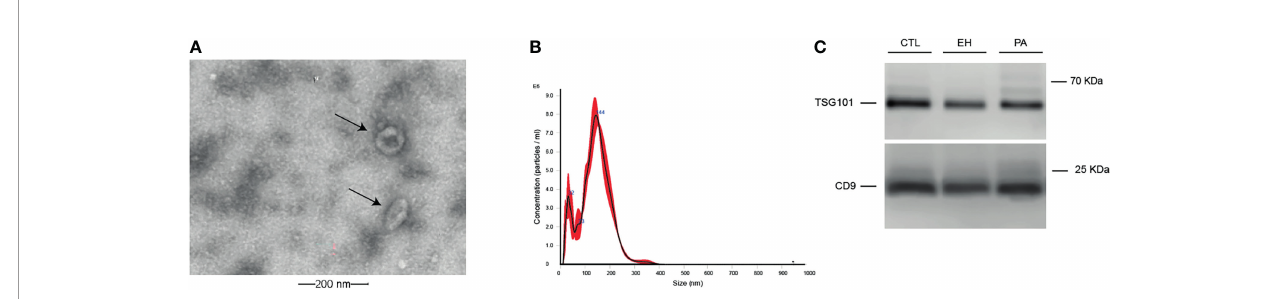
FIGURE 6 | Characterization and quanti fi cation of urinary EVs. (A) . Identi fi cation of uEVs by Transmission Electron Microscopy (TEM) (indicated by black arrows). (B) Representative size distribution plot from uEVs using a NanoSight NS300 instrument. (C) . Western blot of classic extracellular vesicles markers TSG101 and CD9.